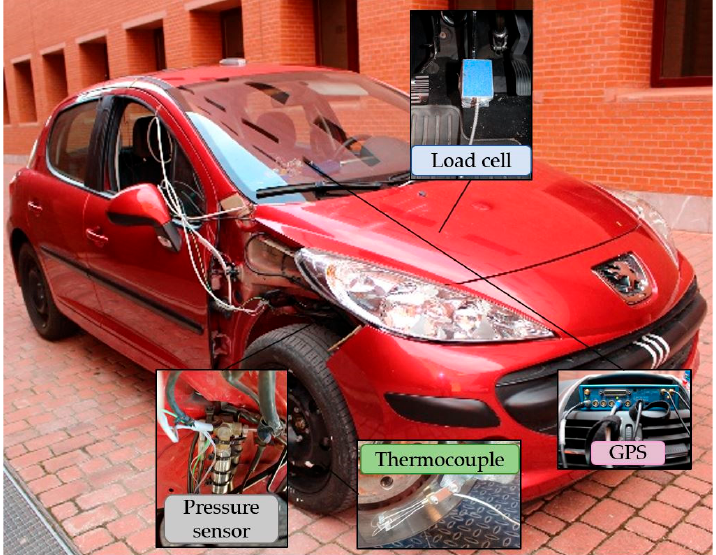
Figure 2. Instrumented vehicle.